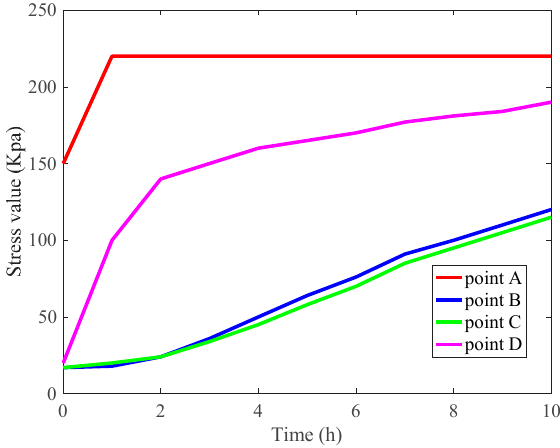
Figure 13. Stress change at the interfaces between components.